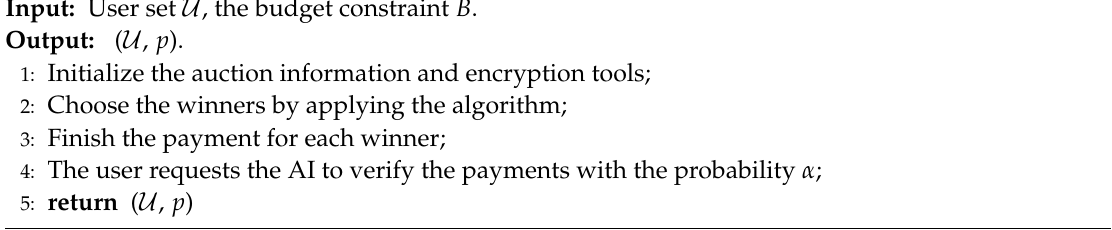
Algorithm 7 PVI-S // Privacy-Protection Verifiable Incentive Mechanism for Crowdsensing Application with Sensing Submodular